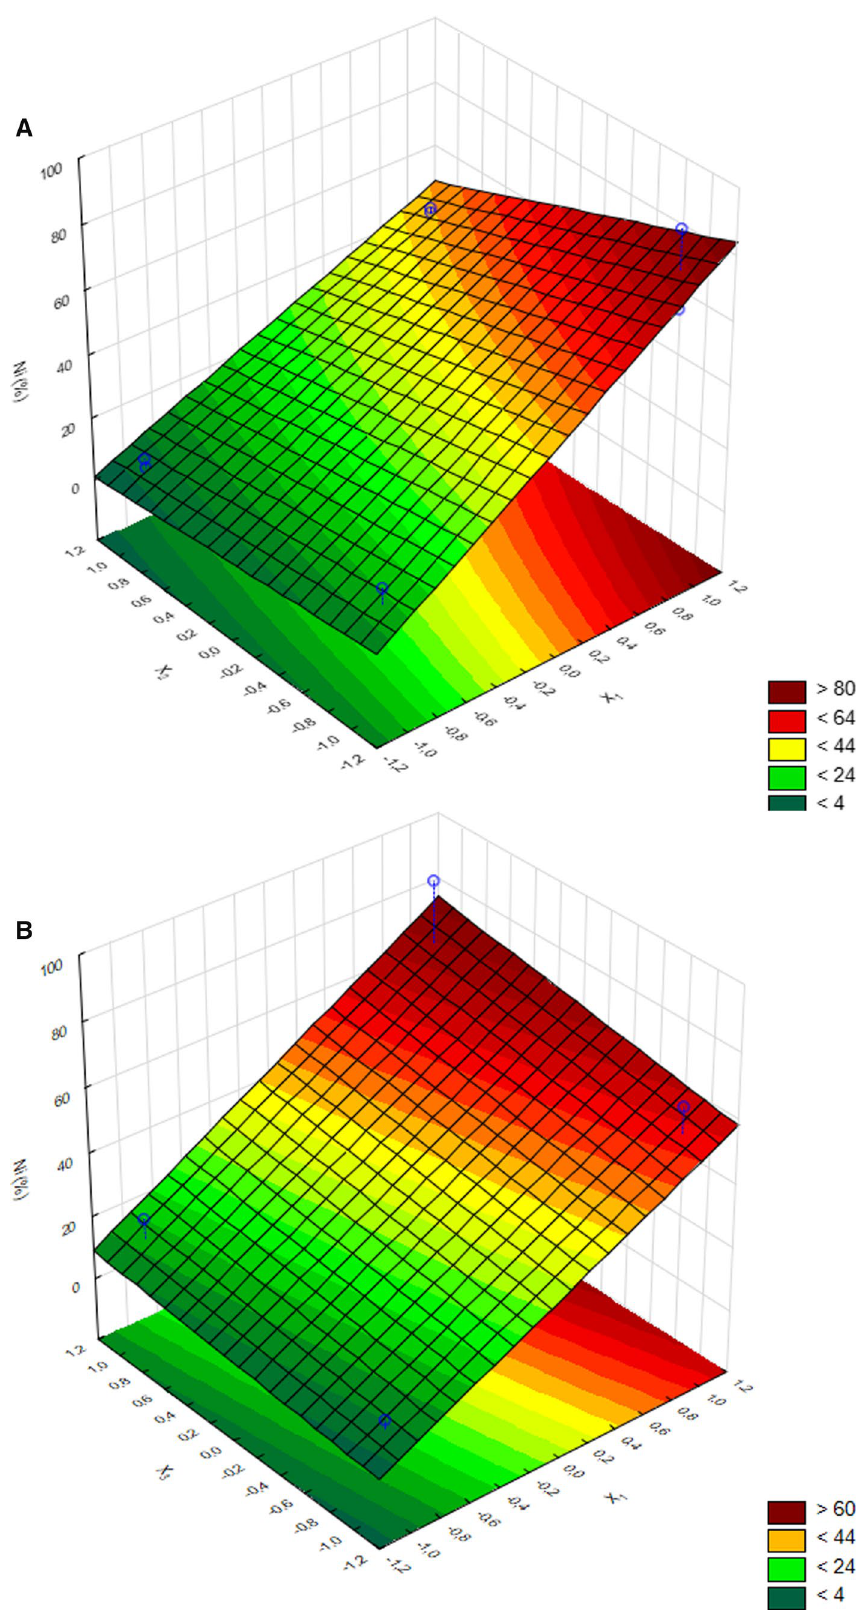
Fig. 1 Response surface plot showing the effect of Ni extrac- tion ( Y 1 ) as a function of a glucose ( x 1 ) and Ni-laterite ore ( x 2 ), at a fixed time of contact ( x 3 = 14 days); and b glucose ( x 1 ) and time of contact ( x 3 ), at fixed Ni-laterite ore concentra- tion ( x 2 = 0.75%, w/v) according to a 2 3 two-level full factorial